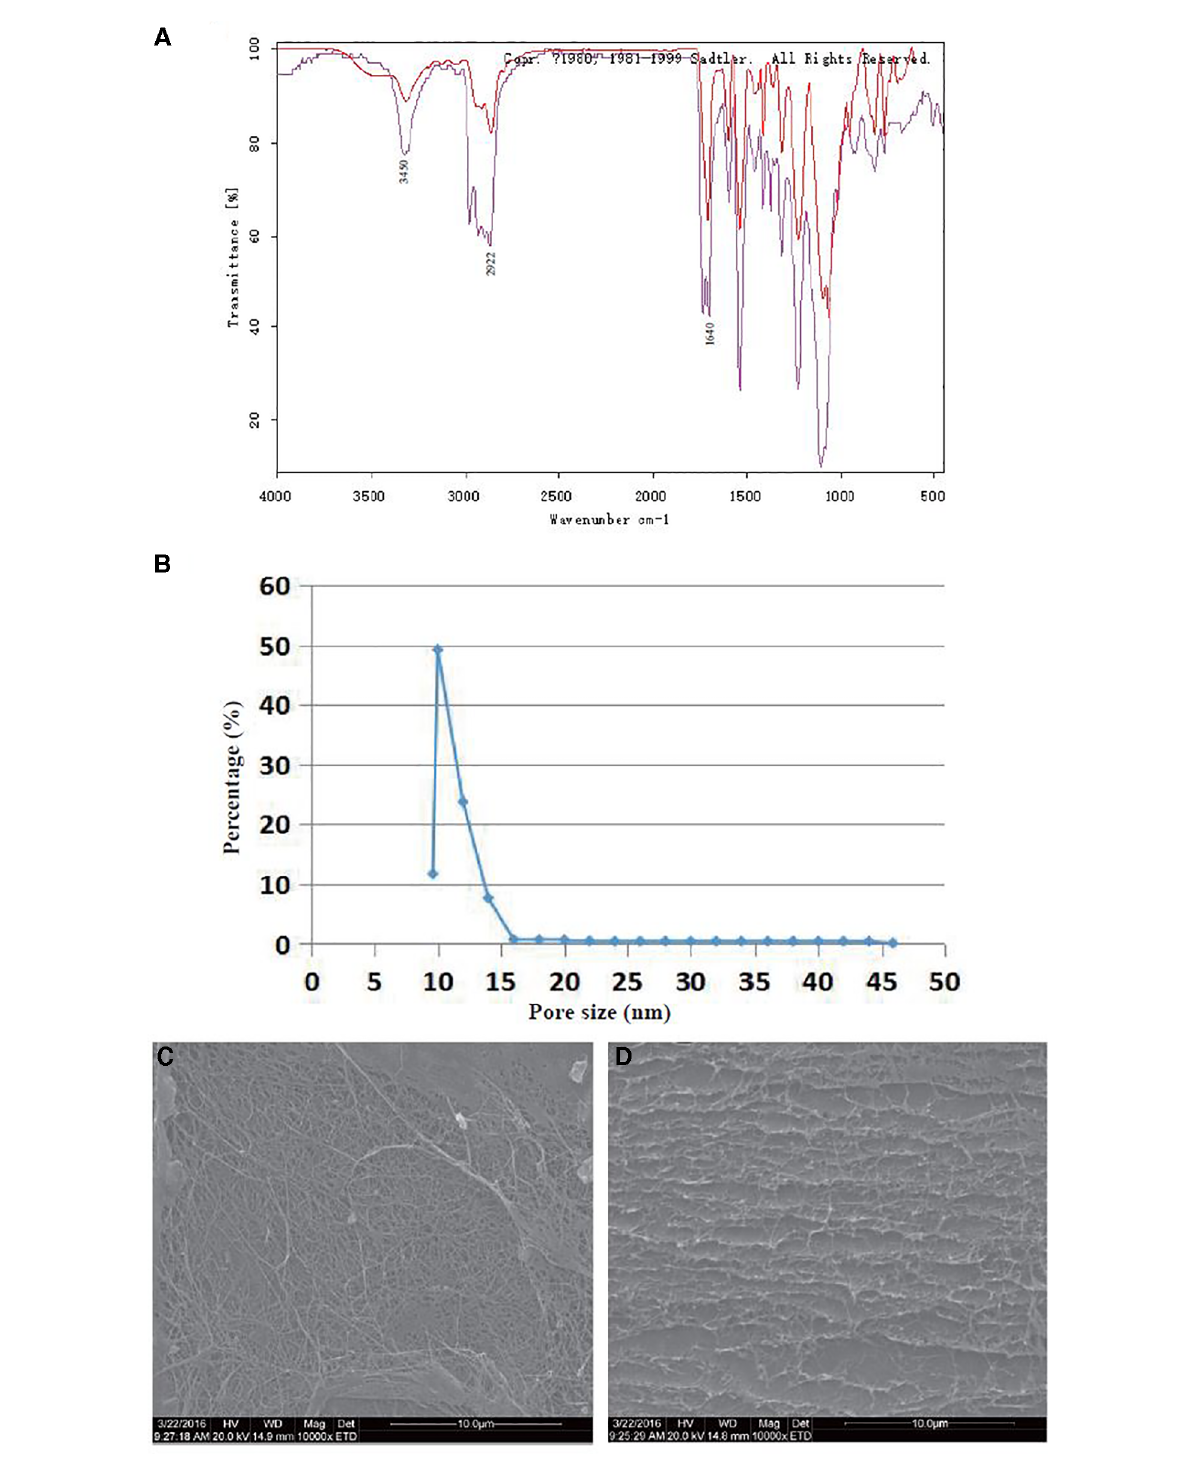
FIGURE 1 Morphological and chemical characterization of the BCM. ( A ) FT-IR spectra of the BCM: purple line, crude BCM; red line, puri fi ed BCM. ( B ) Pore size distribution of the BCM. ( C ) SEM images of the BCM surface (×10,000). ( D ) SEM images of the BCM cross-section (×10,000). ( n